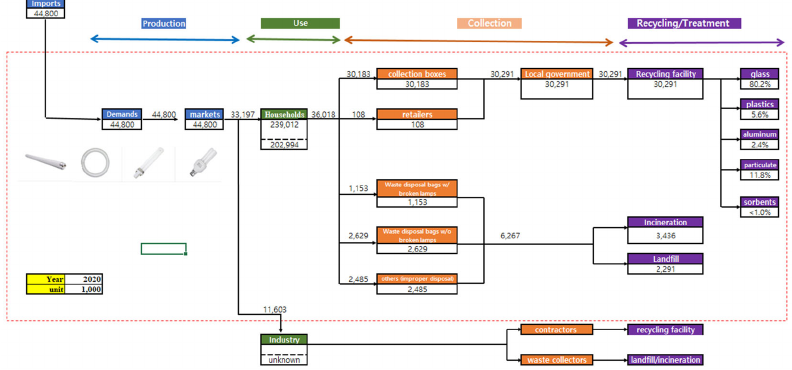
Figure 5. Material flow of fluorescent lamps by life cycle in South Korea (2020).